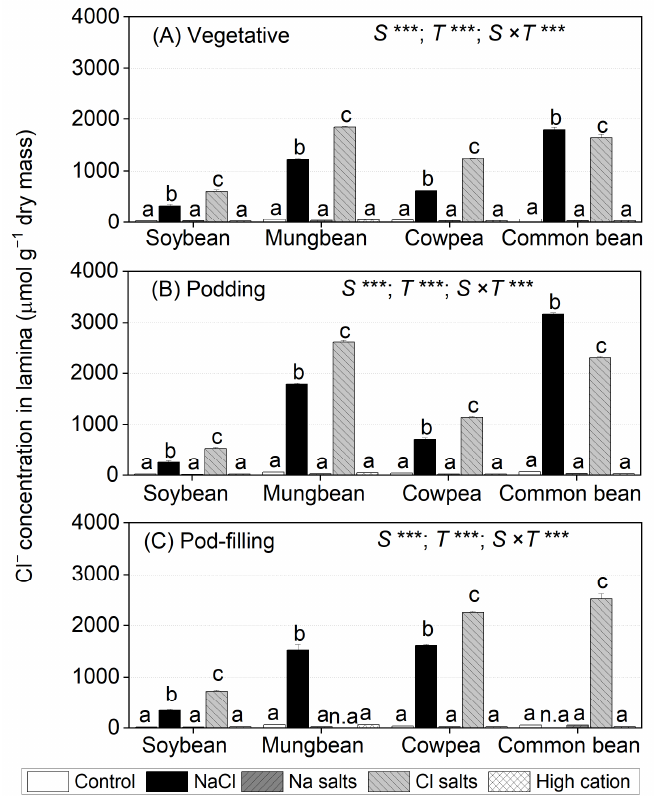
Figure 3. Cl − concentration lamina of soybean, mungbean, cowpea, and common bean grown in control (non-saline), 100 mM NaCl, 100 mM Na + (without Cl − ), 100 mM Cl − (without Na + ), and high-cation negative control (K + , Mg 2+ , and Ca 2+ equivalent to those in the 100 mM Cl − treatment) treatments. The salts used in the various treatments are given in Table 1. The treatments were imposed on 13-day-old plants and sampled after ( A ) 15 (vegetative stage), ( B ) 36 (podding stage), and ( C ) 57 (pod-filling stage) days of treatment. The values are means ± SE ( n = 4). Significant differences for treatment means within each species are indicated by different letters (a–c) ( p = 0.05). The probability levels for two–way ANOVA were used to compare species (S), treatment (T), and species × treatment interaction (S × T) effects (*** p < 0.001). Note: Mungbean subjected to Cl − (without Na + ) and common bean subjected to the NaCl treatment did not have enough green leaf lamina at the pod-filling stage for ion analysis, as indicated by n.a. Cl − concentrations in shoots, roots, petioles, and stems are presented in Table S2, Figures S4 and S5; Cl − concentrations in flowers, pod walls, and seeds are presented in Figure